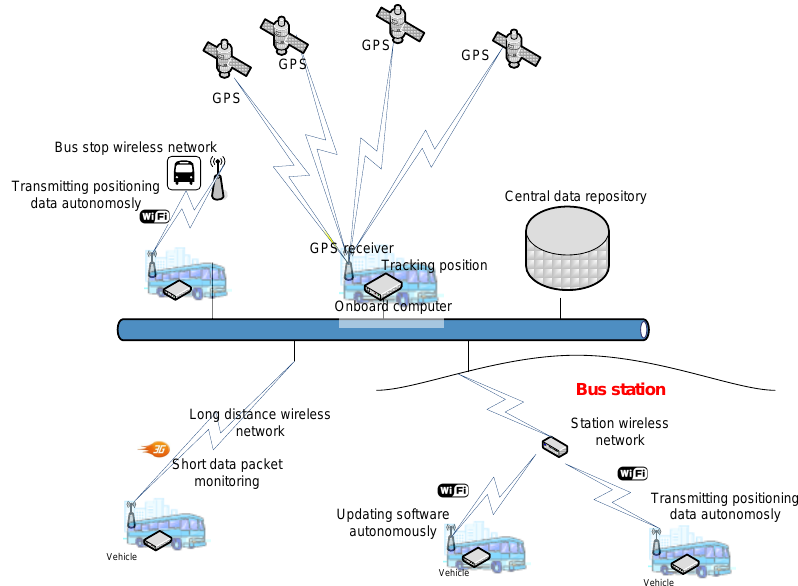
Figure 1. General view of the